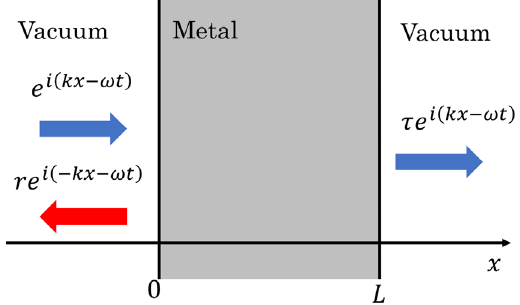
FIG. 11. Schematic of laser-field irradiation of aluminum thin